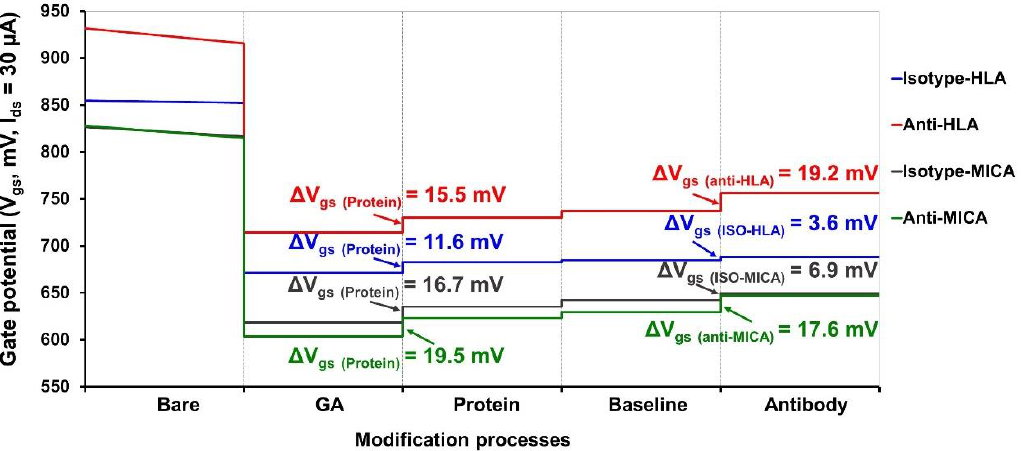
Figure 8. The surface potential measured in each module of the surface modification. The electrical monitoring was performed in five modules, including bare Si 3 N 4 surface, APTES-GA functionalized surface, protein-immobilized surface, baseline, and antibody-binding. The experiment was carried out by using the optimal protein concentration of HLA and MICA proteins with 40 µg/mL of each antibody.